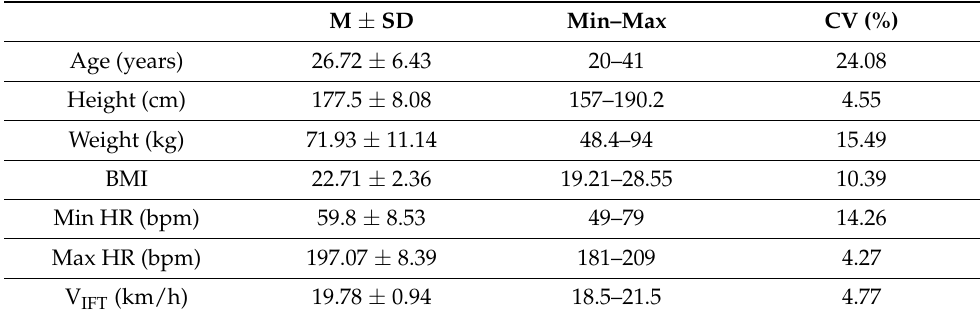
Table 1. Descriptive statistics of the sample.